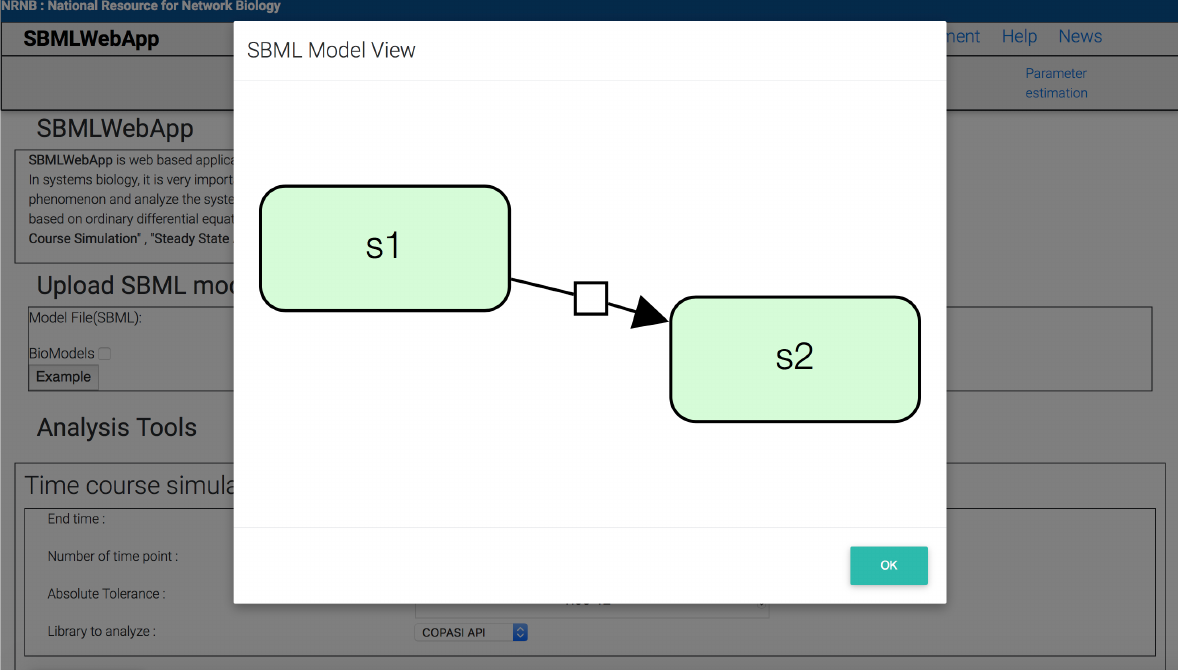
Figure 1. SBML graph visualization of a simple example model consisting of the species s1 and s2. The graph shows the relationships between species and reactions in the SBML model. Species with a reactant role have no arrow (s1), whereas species with a product role have an arrow